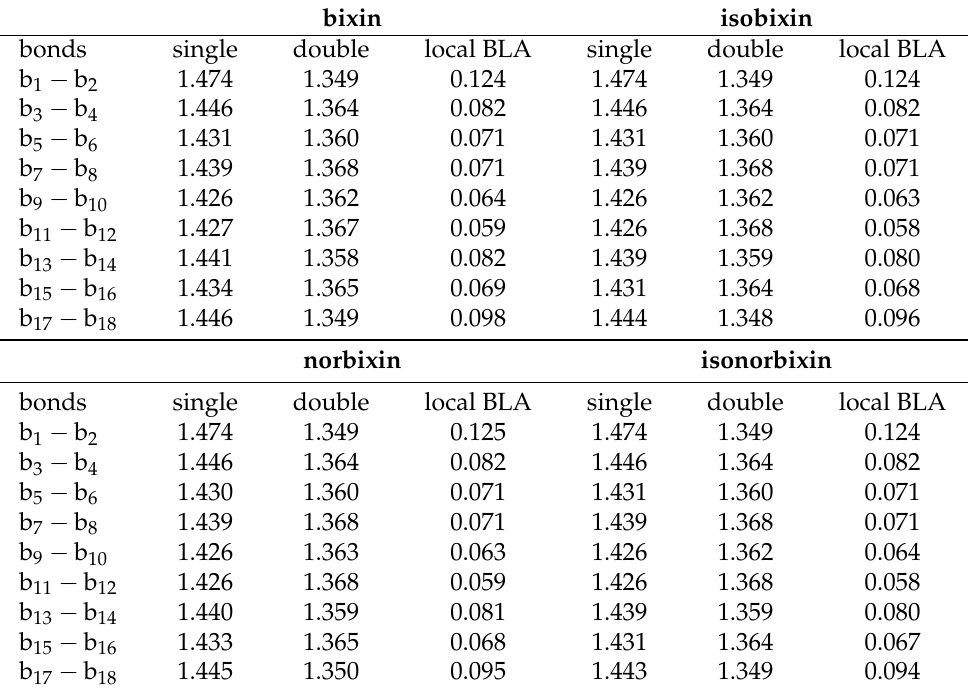
Table A3. Single-double bonds and local BLA values (Å) of the molecular dyes in gas phase. These results were obtained by employing the M06/6-31+G(d,p) level of